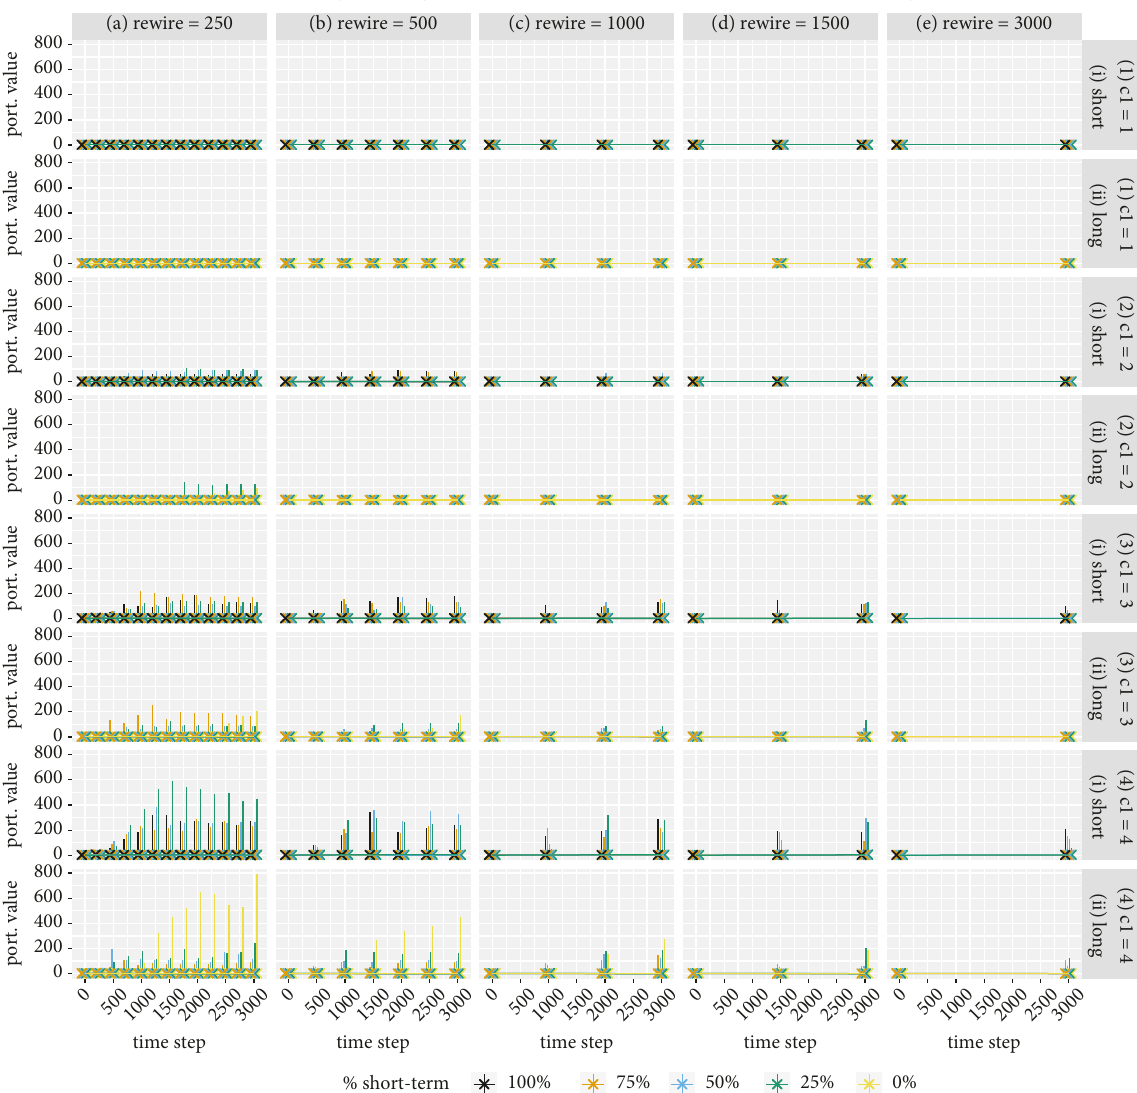
Figure 10: The dynamics of wealth creation. The plot summarizes the distribution of wealth (the agent’s portfolio value), per the y-axis, labelled port. value. The vertical lines represent the range of wealth, while the stars represent the median. The range updating occurs after each rewiring